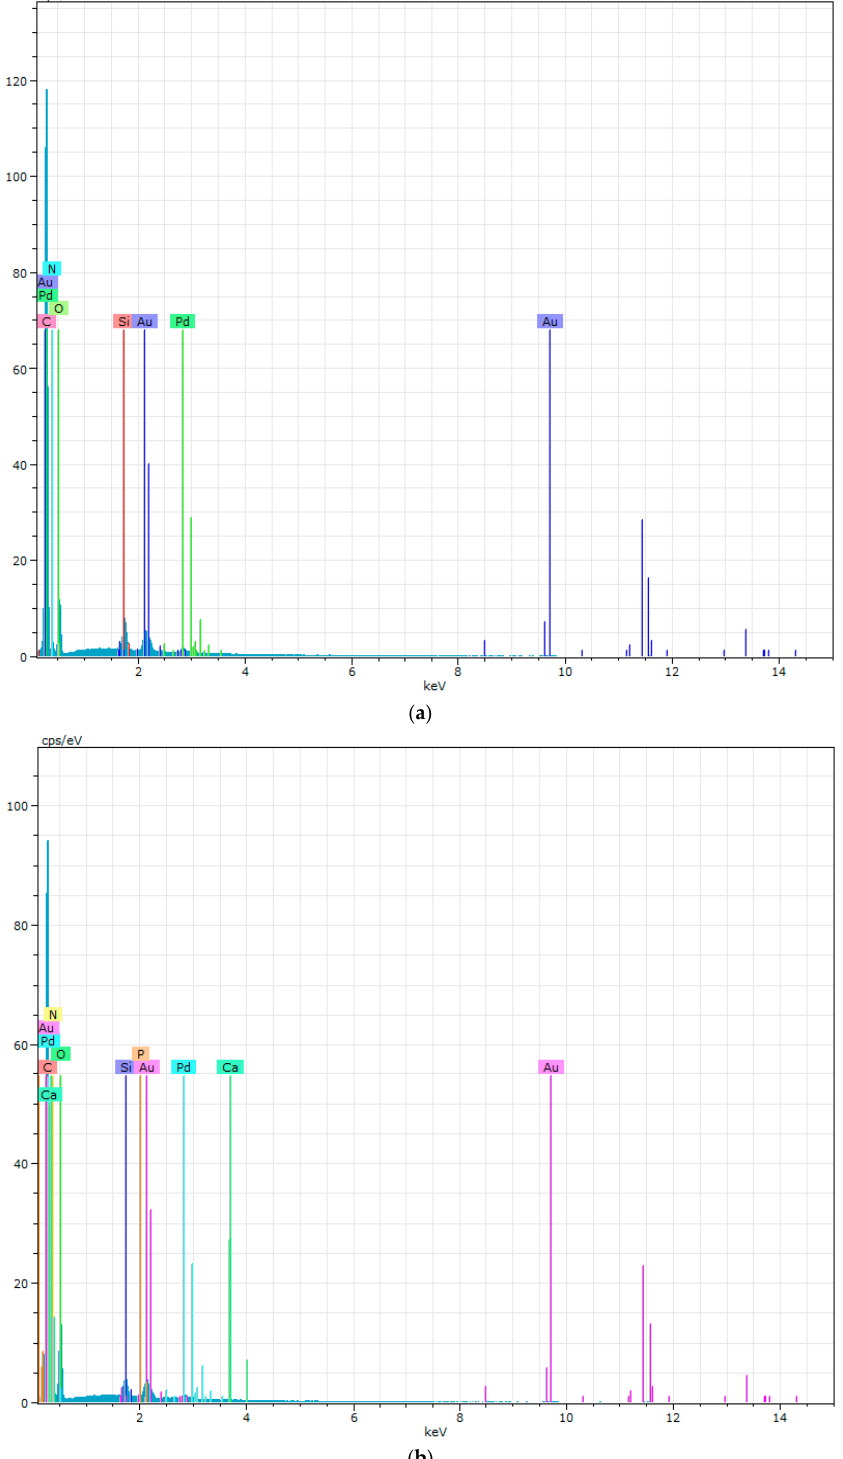
Figure 10. The EDX of PURs ( a ) and PURs-M ( b ) before calcification study.